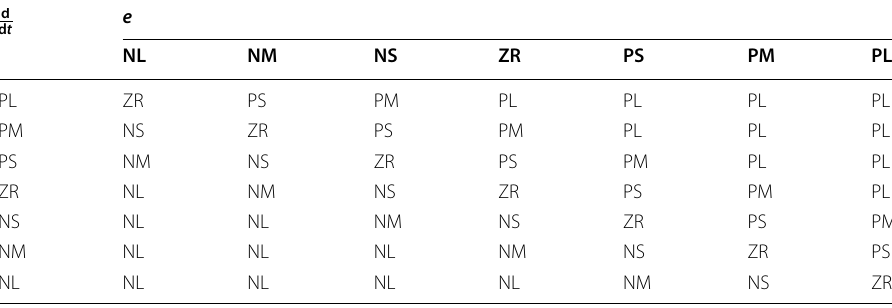
Table 7 Rule base for fuzzy